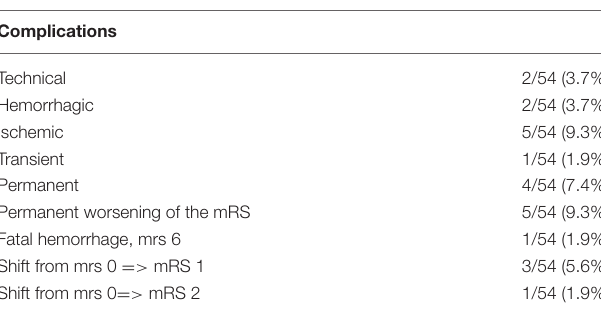
TABLE 4 | Complications.